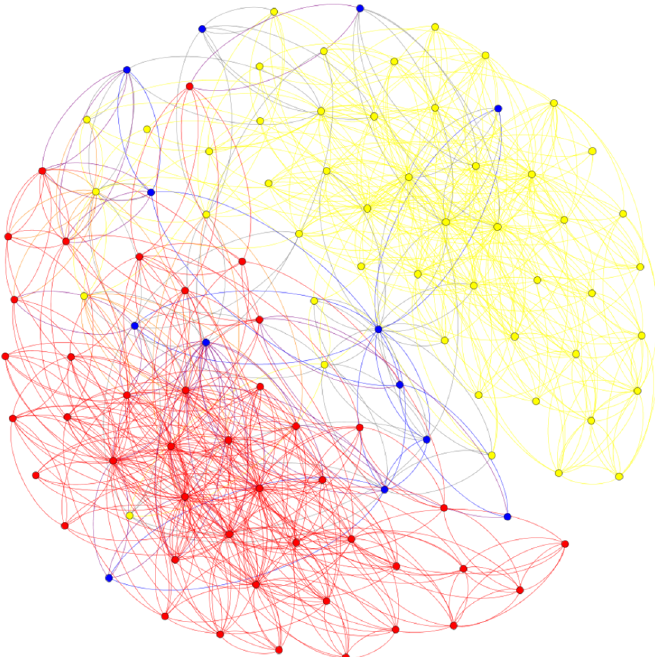
Fig 10. Political books dataset: The ‘real’ community structure is represented. We can see yellow nodesthat have more colored links than yellow, indicating more links in the other two communities.